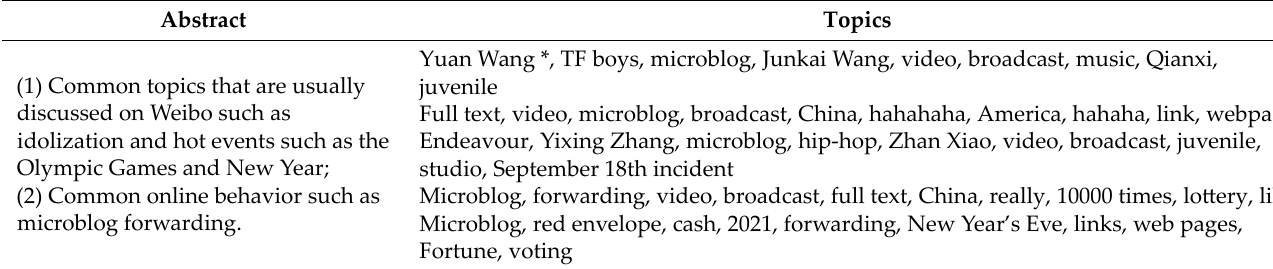
Table 3. Topics and abstract of topics for the control group.